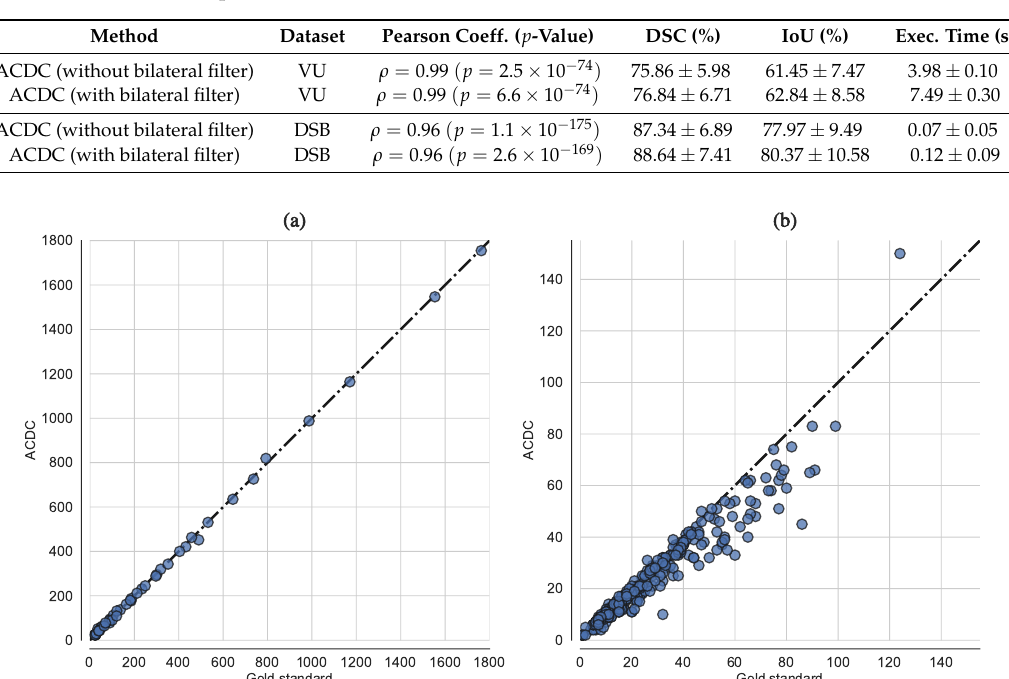
Table 1. Evaluation metrics on cell counting and segmentation achieved by ACDC (with and without bilateral filtering) on the analyzed time-lapse microscopy VU and 2018 DSB datasets, comprising 46 and 301 images, respectively. The results for the DSC and IoU metrics, as well as the execution time measurements, are expressed as mean value ± standard deviation.